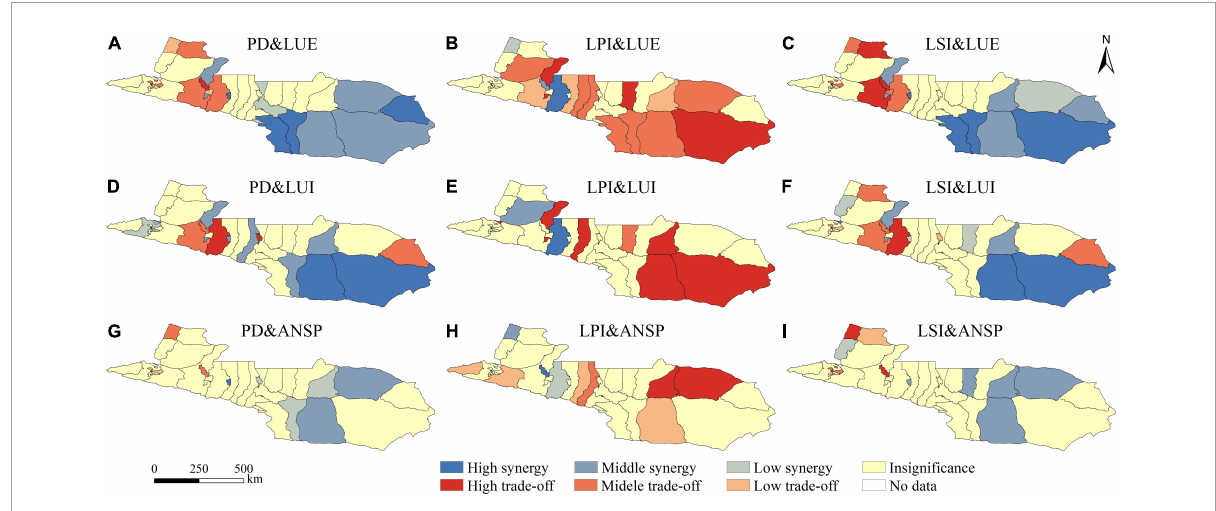
FIGURE9 The spatial patterns of trade-offs/synergies between each pair of land use dominant and recessive morphology indices. Alashankou City was set in 2012, so the indices based on statistical data (LUE and ANSP) before its establishment is unavailable, which is denoted using blank